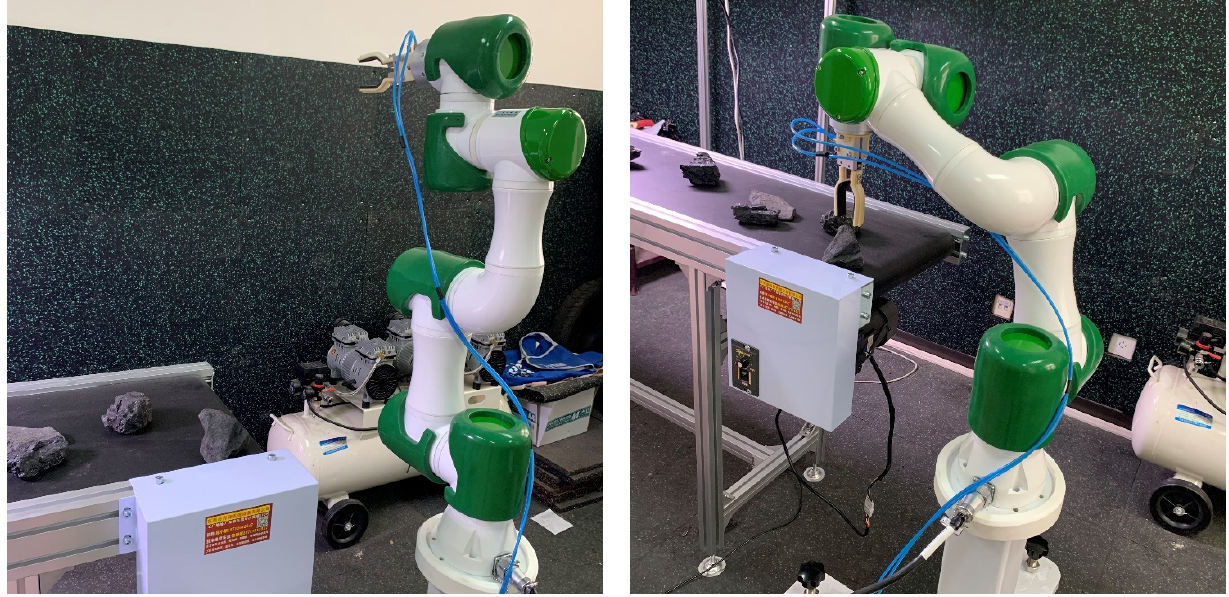
Figure 8. Robot sorting experiment based on multi-objective motion planning model. Table 3. Comparison of sorting rate under motion